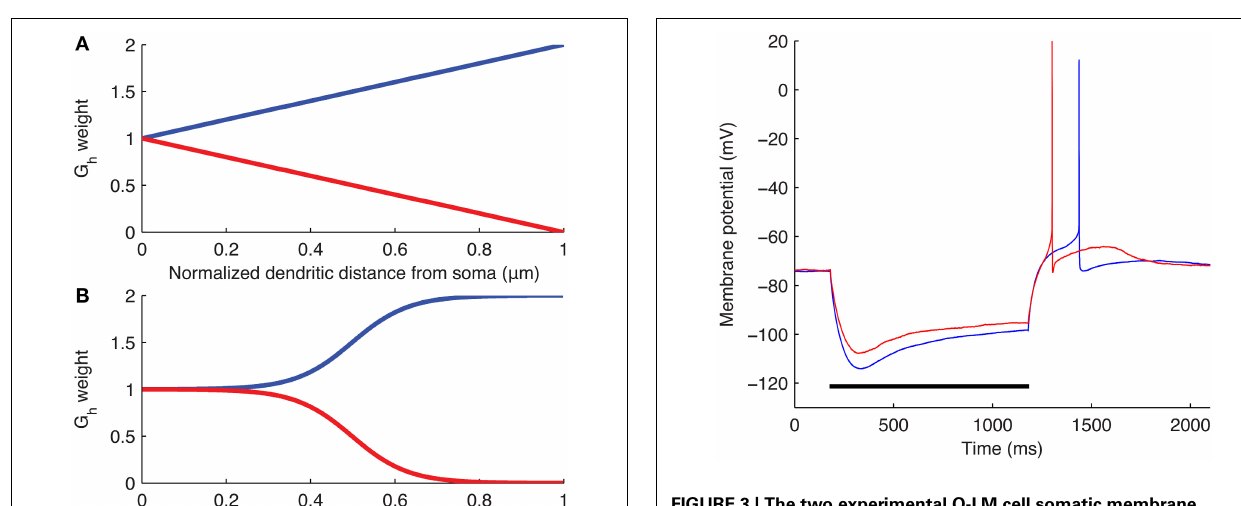
FIGURE 3 | The two experimental O-LM cell somatic membrane potential traces used in the optimization work. Somatic membrane voltage response to a − 90pA hyperpolarizing current injection step for two experimental O-LM cells: cell 4525#4 (blue) and cell 4610#2 (red). Horizontal black bar shows time of application of − 90pA current injection